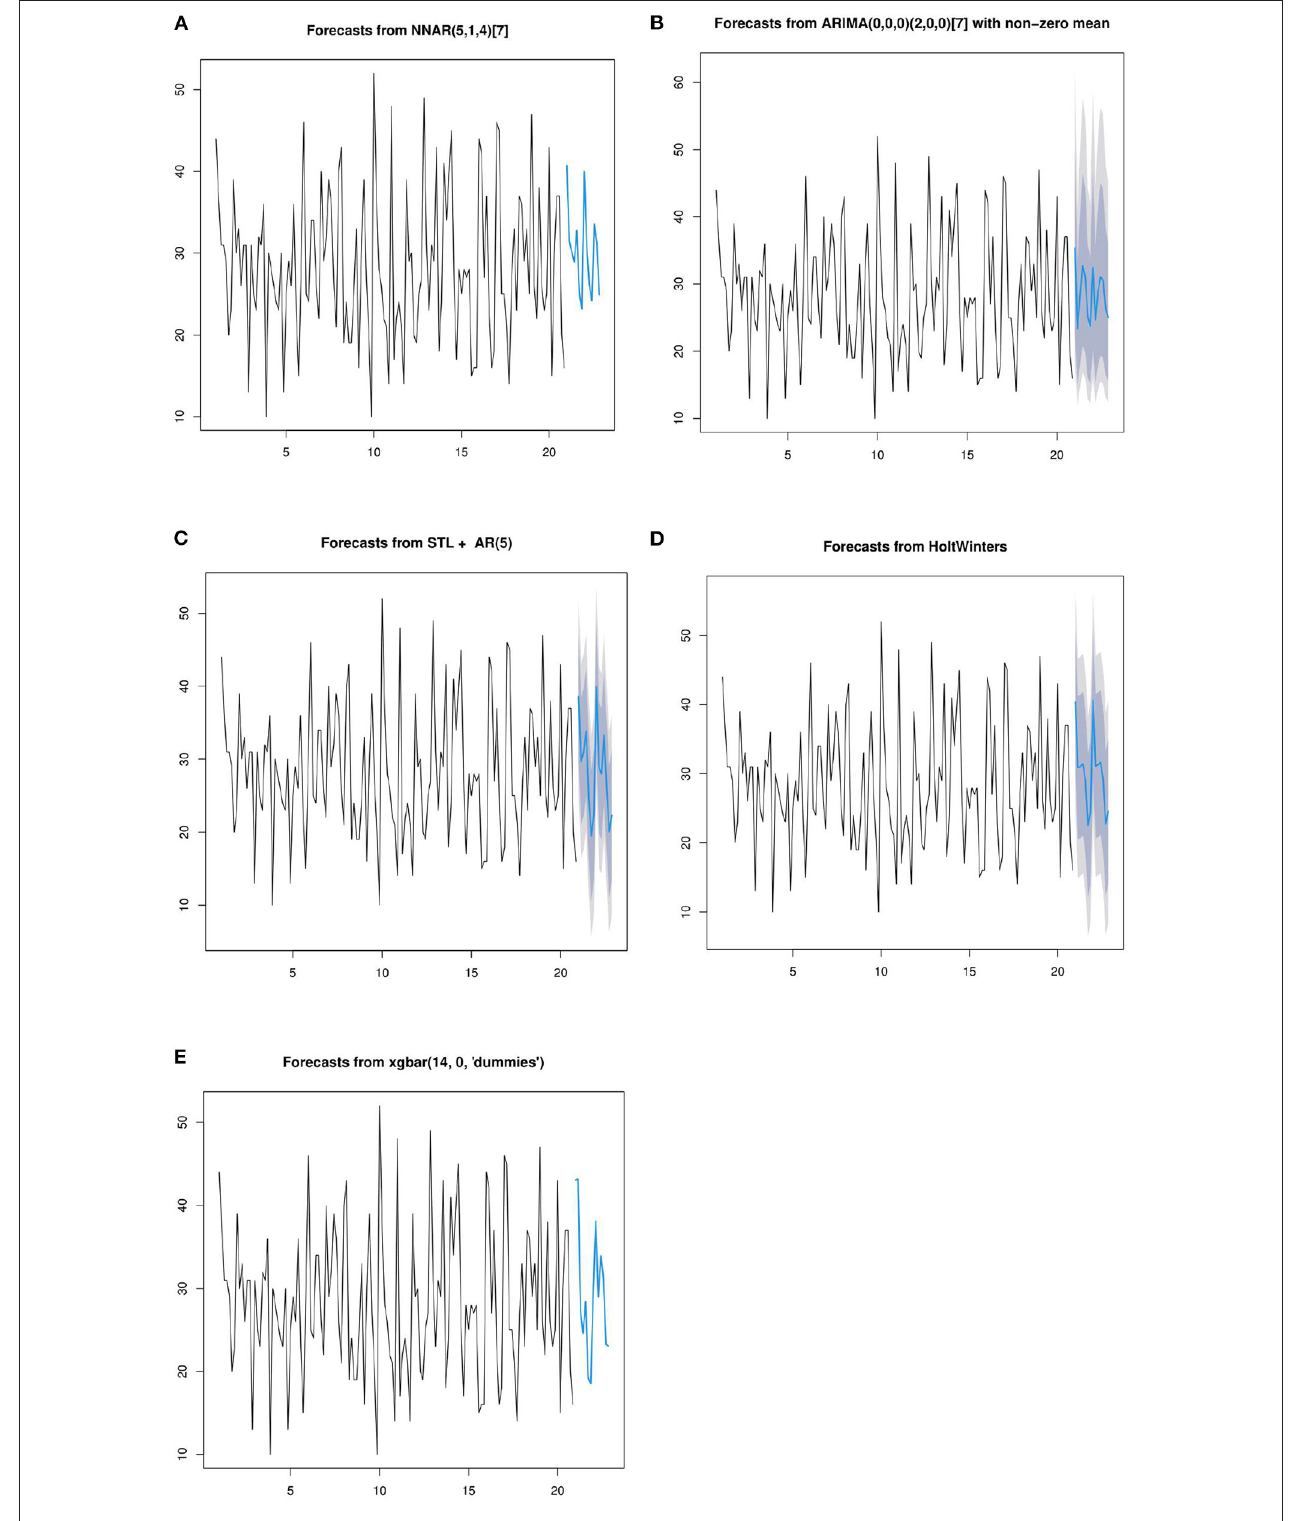
FIGURE 9 | Forecasts from NNAR (A) , ARIMA (B) , STL (C) , HoltWinters (D) , and XGBoost (E) .